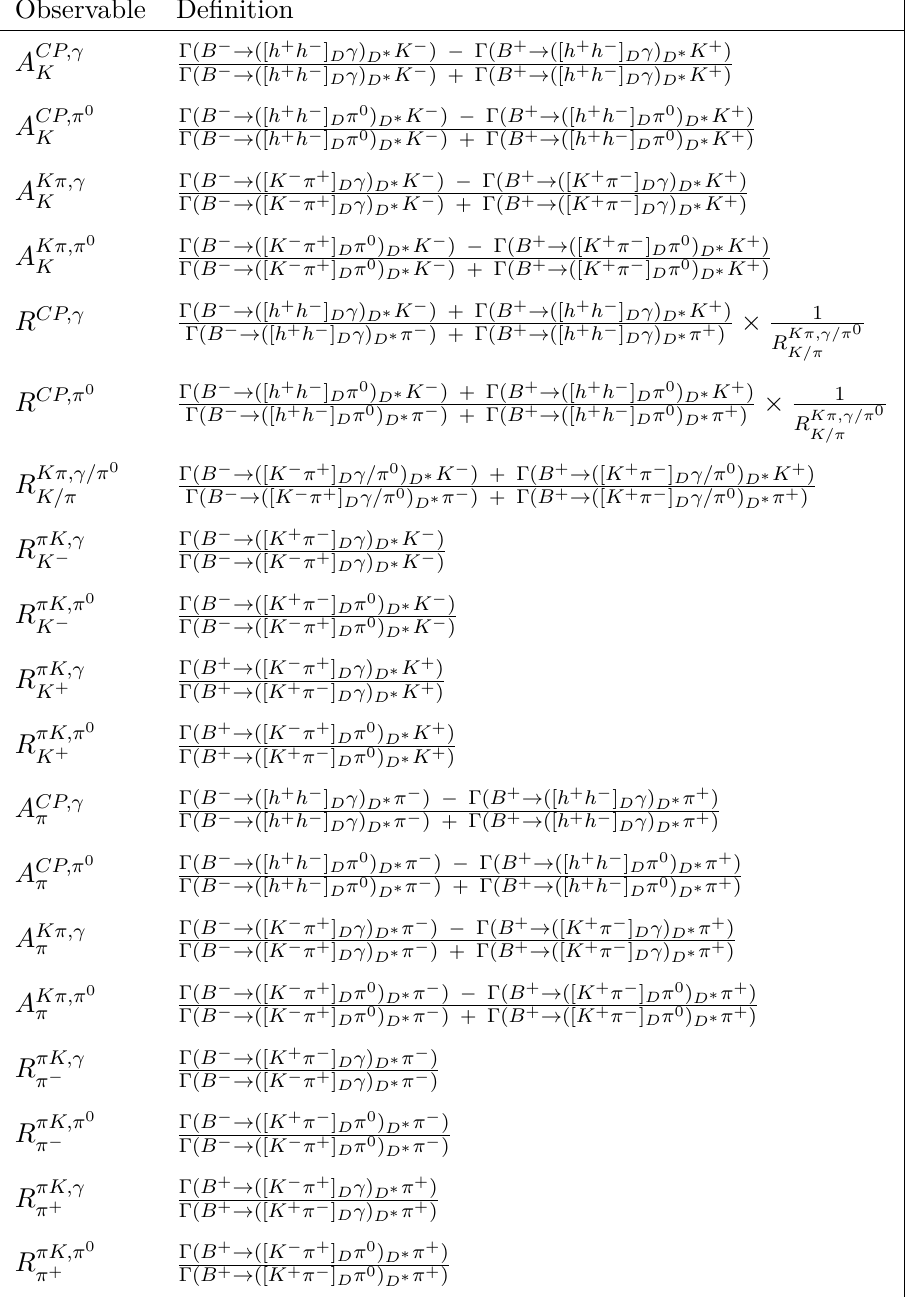
Table 2 . The 19 CP observables measured using B − → D ∗ h − decays, defined in terms of B meson decay widths. Where indicated, h + h − represents an average of the D → K + K − and D → π + π − modes. The R observables represent partial width ratios and double ratios. The A 0 observables represent CP asymmetries. The R Kπ,γ/π observable is an average over the D ∗ → Dπ 0 K/π and D ∗ → Dγ